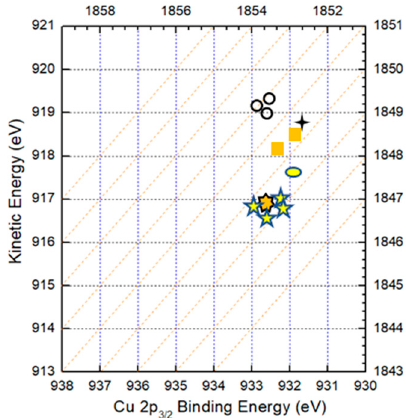
Figure 5. Auger parameters of Cu in Cu metal, CZTS and CuS compounds. The ( ), ( ), ( ) and ( ) symbols show the reference data of Cu metal, Cu 2 S, CuS and CZTS in the CZTS film, respectively. The ( ) symbol shows the experimental data on the surface in this work. ( ) shows the experimental data of the CZTS in the bulk.